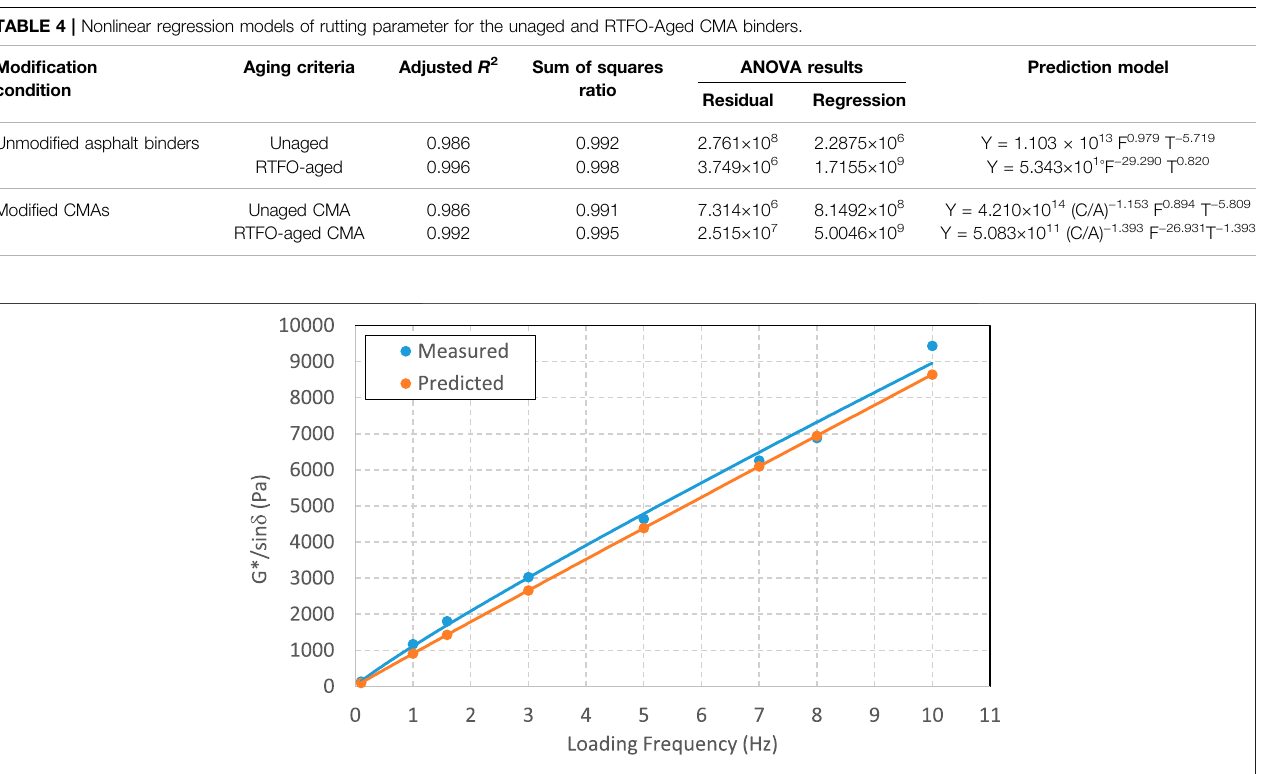
FIGURE 4 | Measured and predicted G*/sin δ value versus loading frequency for the unaged unmodi fi ed asphalt binder at 58 ° C.